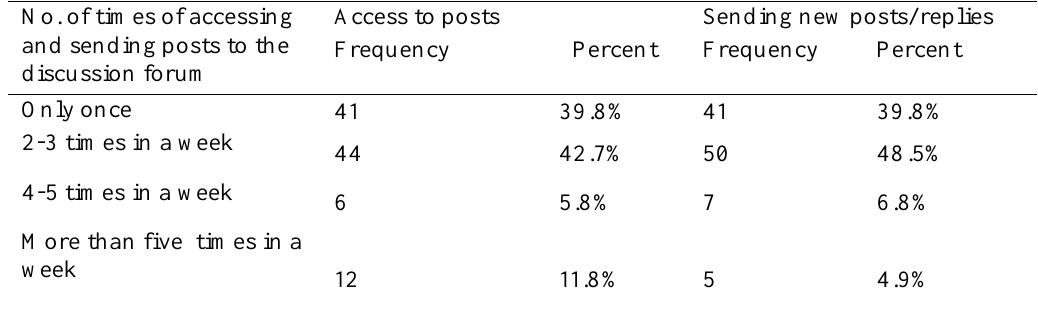
Students’ Level of Access and Reply to Post in an Online Group Activity (N=108) No. of times of